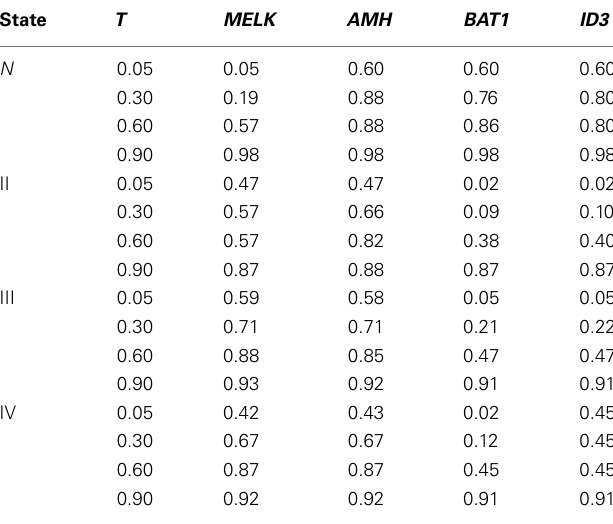
Table 3 | List representative genes of glioma which have big difference in the size of cascading failure in different networks.